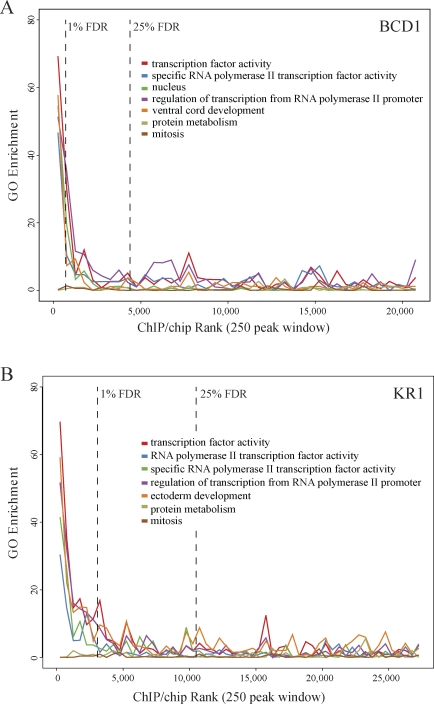
Genes That Control Development Are Highly Bound In VivoThe five most enriched GO ([98]) terms in the 1% FDR bound regions for each factor were identified (enrichment measured by a hypergeometric test). The significance of the enrichment (−log(p-value)) of these five terms plus those for two negative controls (protein metabolism and mitosis) in nonoverlapping windows of 250 peaks are shown down to the rank list for BCD1 (A) and KR1 (B) as far as the 80% FDR cutoff. The 1% and 25% FDR cutoffs are indicated by vertical dotted lines.